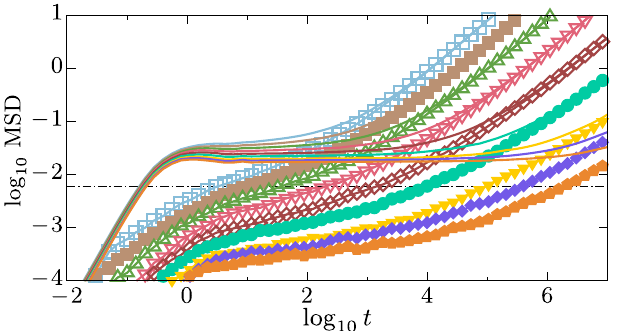
FIG. 3. Mean-squared displacement in 3D deeply supercooled states. From T to T (left to right) in the normal dynamics g MCT Δ ð t Þ (full lines) and in the inherent structures (IS) Δ IS ð t Þ (symbols). The legend is as in Fig. 1(a). The dash-dotted line corresponds to Δ ¼ 6 × 10 − 3 used in Fig. 7 below.